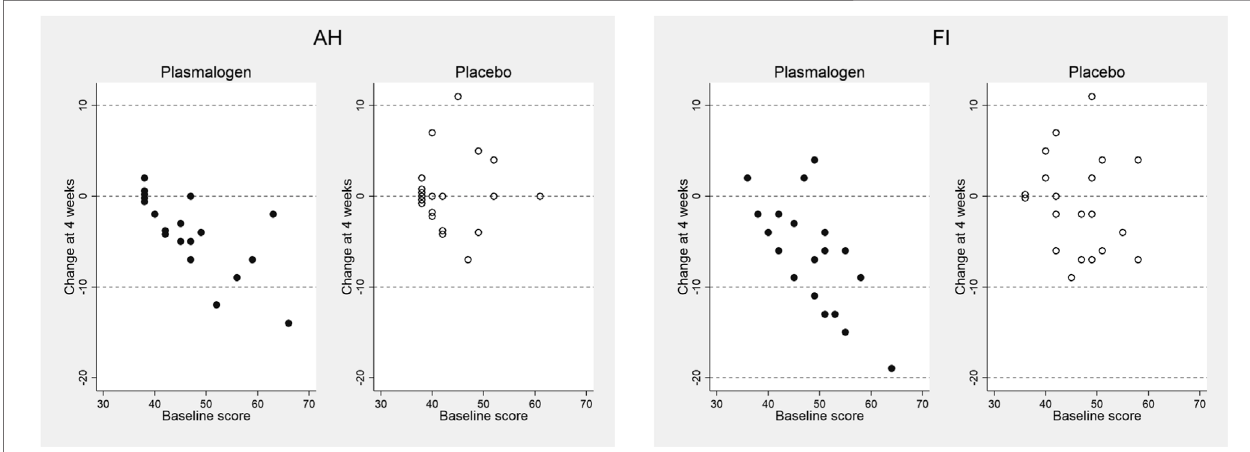
Frontiers in Cell and Developmental Biology |